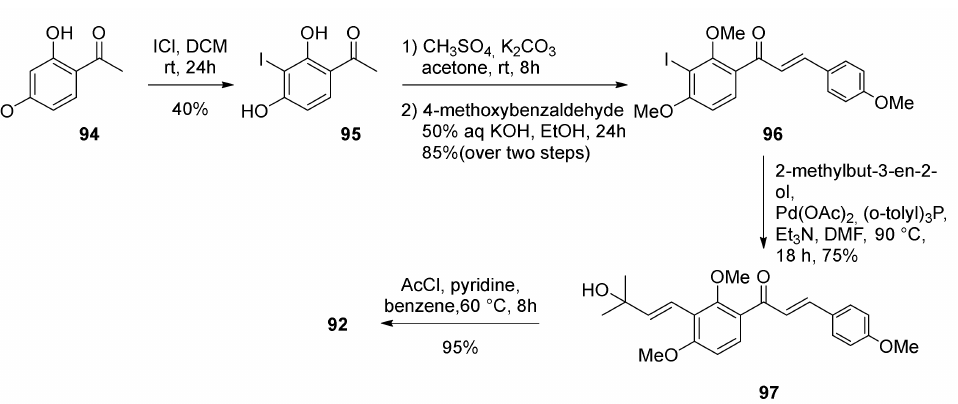
Figure 27. Retrosynthetic plan of kuwanon V and dorsterone methyl ethers ( 90 and 91 ). Diene 92 was synthesized starting from commercially available 2,4-dihydroxyacetophenone 94 , which was subjected to regioselective iodination with ICl to afford aryl iodide 95 . Methylation of compound 95 with (CH 3 ) 2 SO 4 followed by Claisen–Schmidt condensation with 4-methoxybenzaldehyde afforded iodinated chalcone 96 . The diene moiety was in- stalled through Heck reaction of chalcone 96 with 2-methylbut-3-en-2-ol by using Pd(OAc) 2 , ( o -tolyl) 3 P, and Et 3 N as a catalytic system. Allyl alcohol 97 was then easily dehydrated by treatment with acetyl chloride in the presence of pyridine to afford diene 92 (Figure 28).